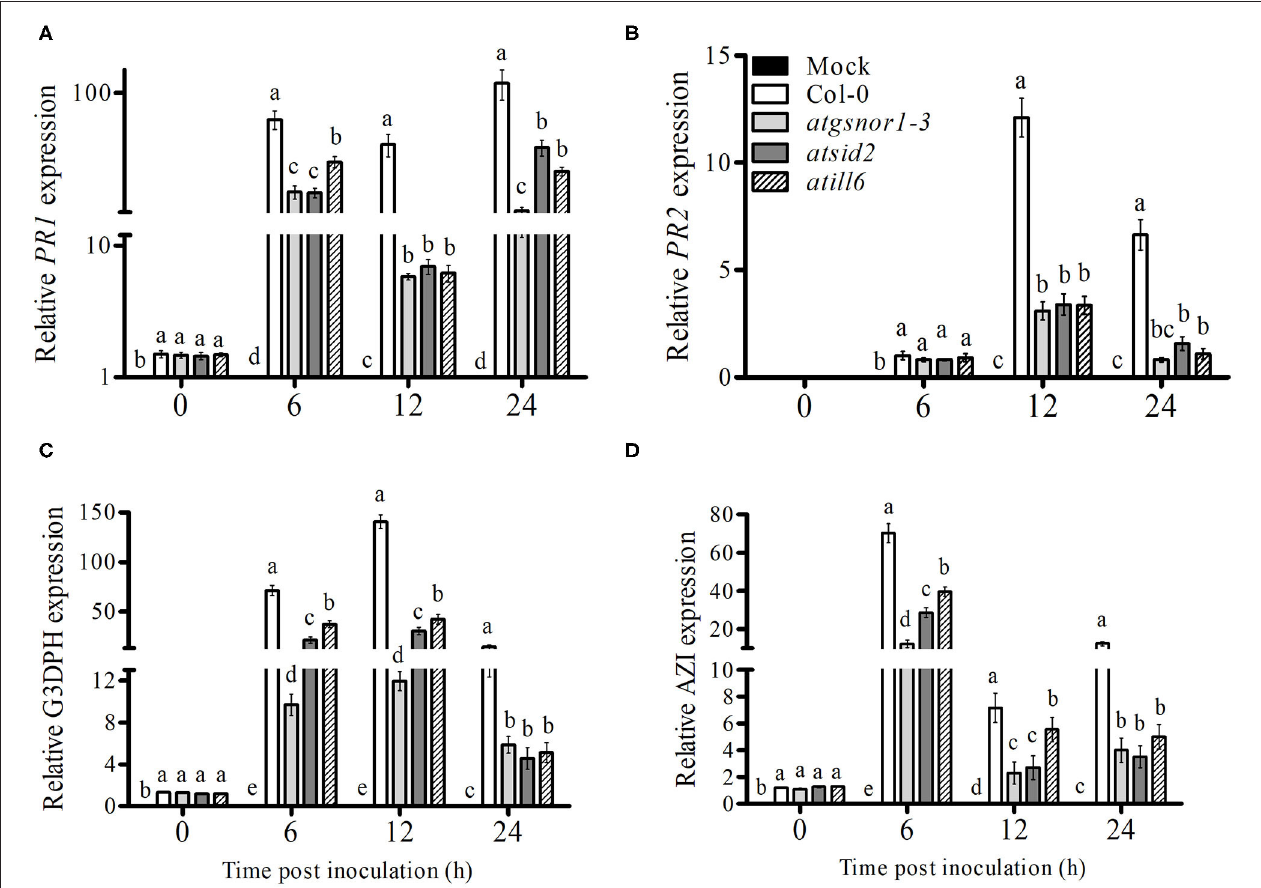
FIGURE 4 | ATILL6 positively regulates plant systemic acquired resistance. (A–D) Relative gene expression of PR1 , PR2, G3DPH, and AZI genes, respectively, in the systemic leaves of the indicated genotypes after inoculation with Pst DC3000 avirulent bacteria. All data points are the means of three replicates, and error bars represent ± standard error. The significant difference between the treatments is represented by (a, b, c, d, e), one-way ANOVA analysis of varience, followed by Duncan’s multiple range test using statistical analysis system (SAS